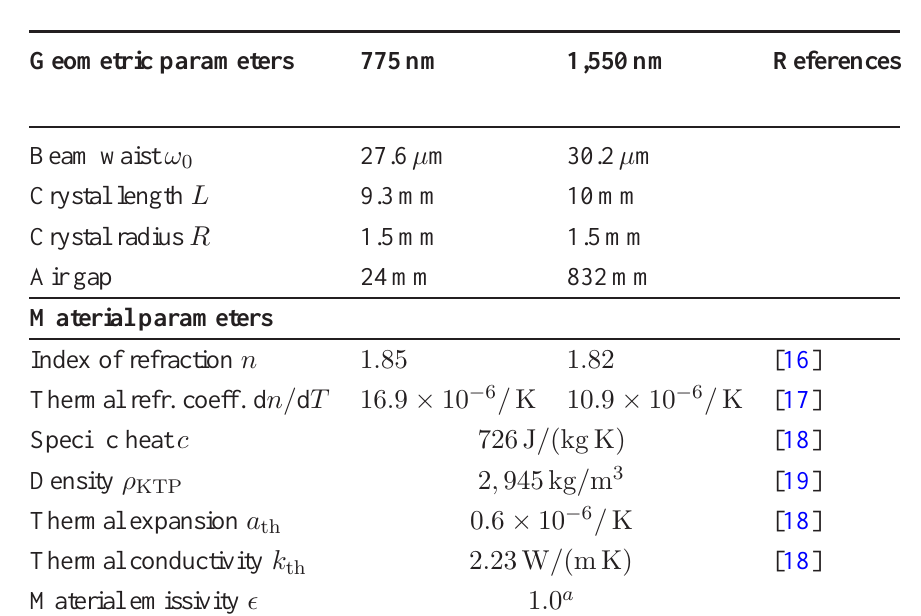
Table 1. Material and geometric parameters of the bow-tie cavity and the half-monolithic cavity used for the